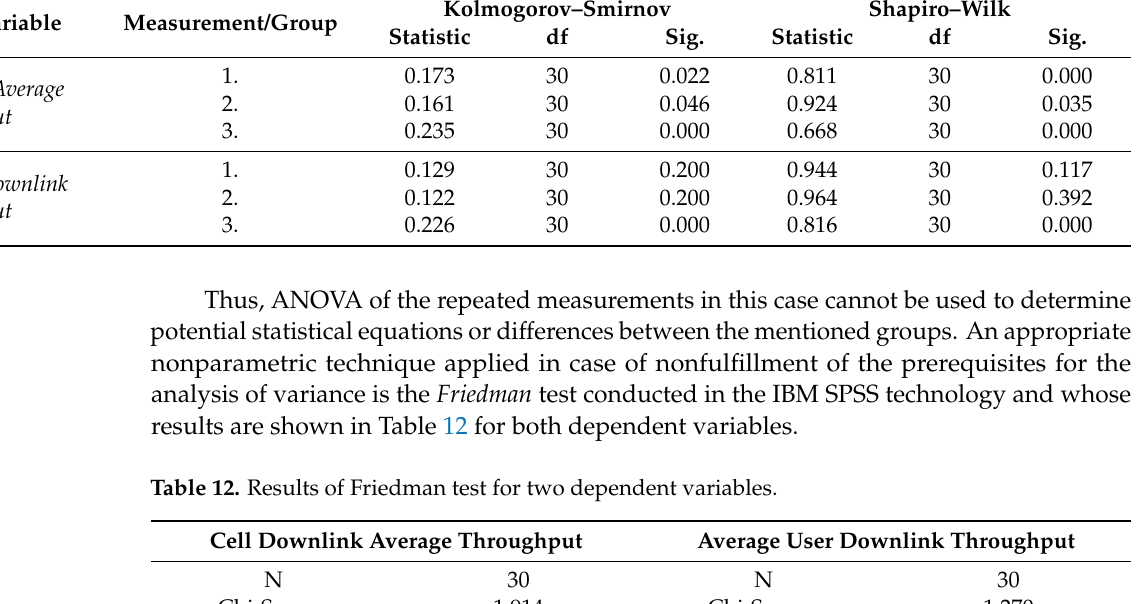
Table 11. Results of the normality tests of the RE by repeated measurements. Kolmogorov–Smirnov Shapiro–Wilk Dependent Variable Measurement/Group